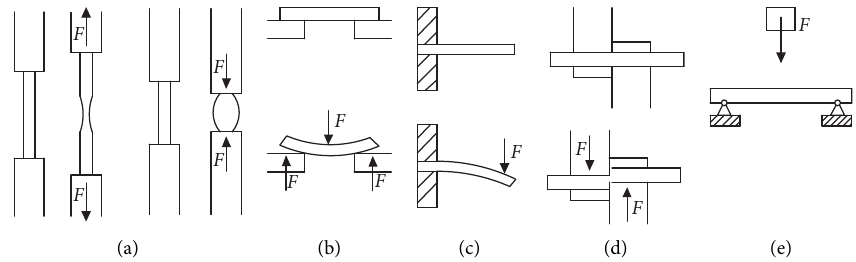
Figure 2: Five common stress diagrams. (a) Tensile stress, (b) compressive stress, (c) bending stress, (d) shear stress, and (e) impact stress.